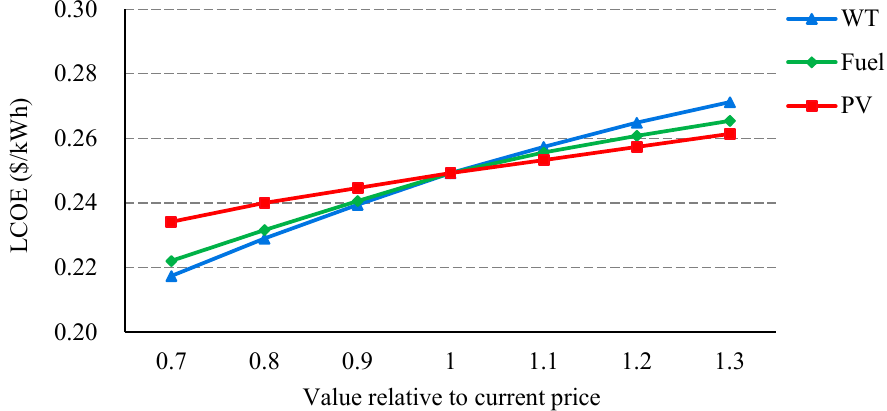
Figure 9. Economic sensitivity analysis.